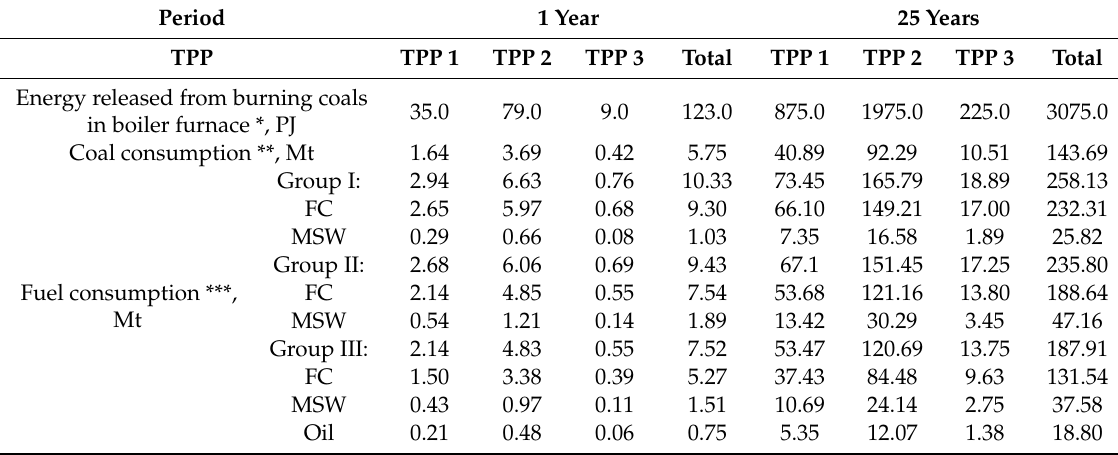
Table 2: group I—11.91 MJ / kg; group II—13.04 MJ / kg; and group III—16.36 MJ / kg. Table 9. Consumption of composite fuel and its